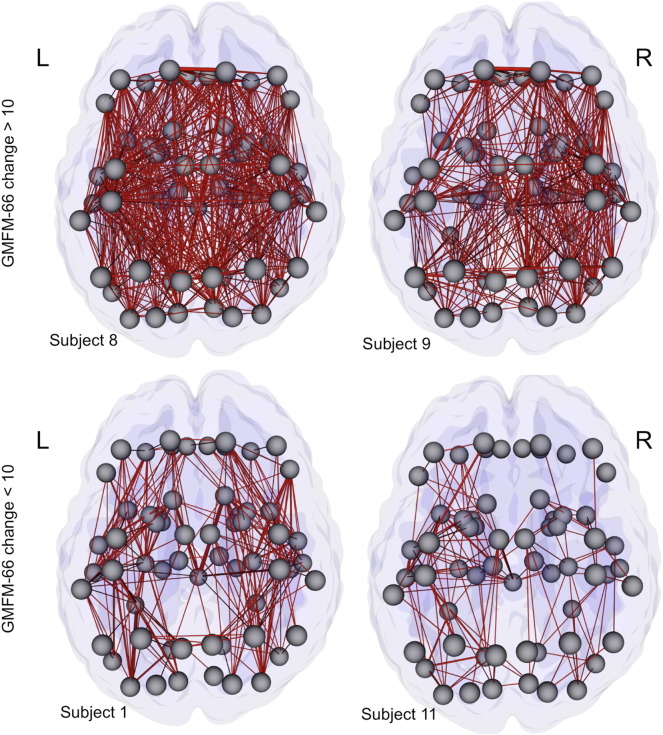
The distribution of connectivity increases over a 2-year period throughout the whole brain for four representative subjects. To generate these connectome maps, the change in each edge was normalized by the total WM volume to minimize the effect of age-related brain volume growth. The gray spheres represent the nodes, and the tubes between the nodes represent positive changes in edges over a 2-year period, with their thicknesses proportional to the magnitudes of the changes.